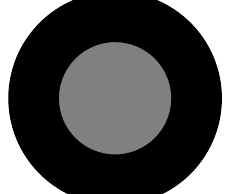
Figure 9 . Phase space density corresponding to a localised superstar made of N A fermions building N 0 giants, together with N (cid:0) N A excited c